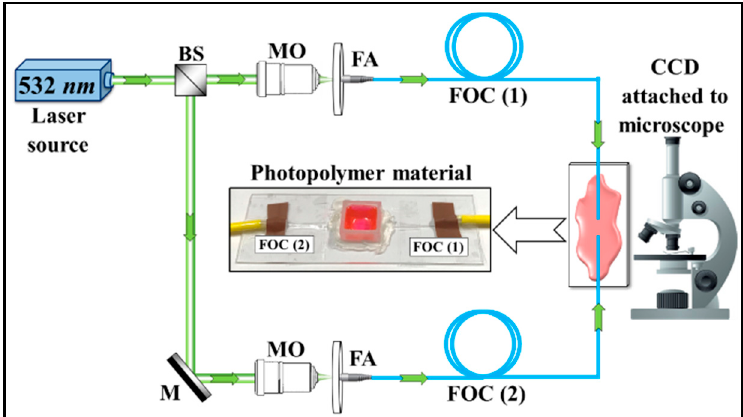
Figure 1. Optical setup for observing self-written waveguide formation through a photopolymer material to observe the dual single-mode fiber optic beam exposure.